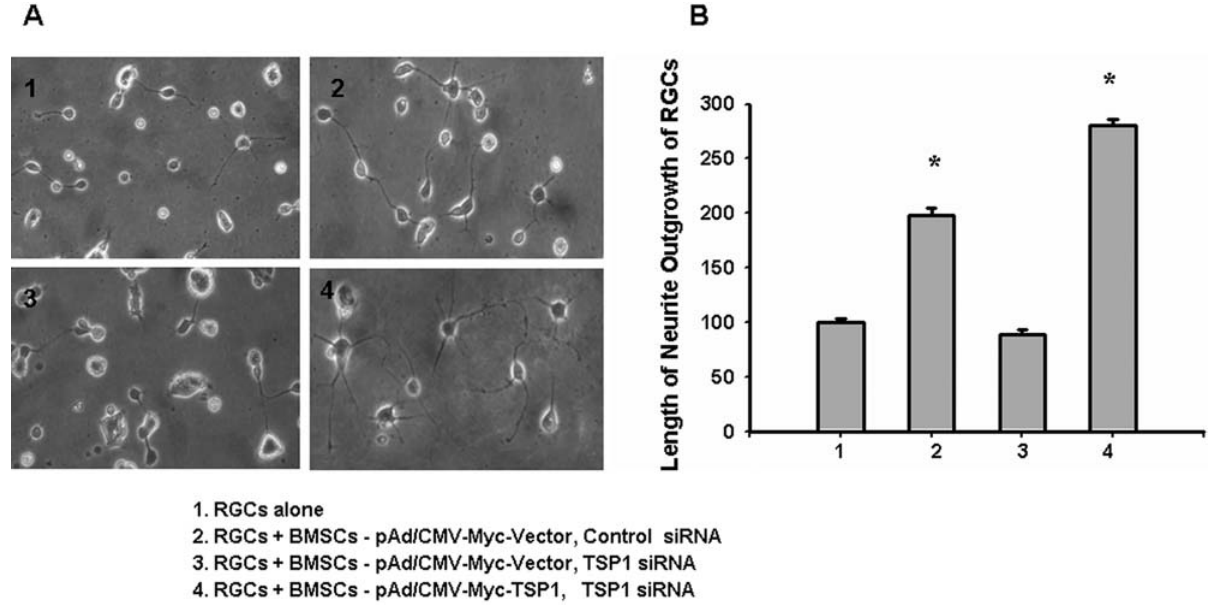
Figure 6. Morphological changes of RGCs after co-culturing with BMSCs with the endogenous TSP-1 silenced by siRNA and rescued by infection with a recombinant adenovirus expressing TSP-1. 48 hours after the first siRNA transfection, BMSCs and RGCs were co-cultured in a transwell system. A , After 5 days, RGC survival was not diminished by co-culturing with BMSCs with TSP-1 silencing, but the degree of RGC neurite outgrowth was lessened (3). B , Bar graph shows the mean and SE of RGC neurite outgrowth in within (10 6 ) microscopic fields after 5 days of co-culturing. RGC neurite outgrowth was enhanced by co-culturing with BMSCs (2), which was diminished with TSP-1 silencing (3) but restored in TSP-1-rescued co-cultures (4) (p=0.038). *p-values # 0.05. (10 pictures were taken randomly under a regular microscope from culturing cells at different time points. The average relative percent of outgrowth of RGCs come from at least three separate experiments).